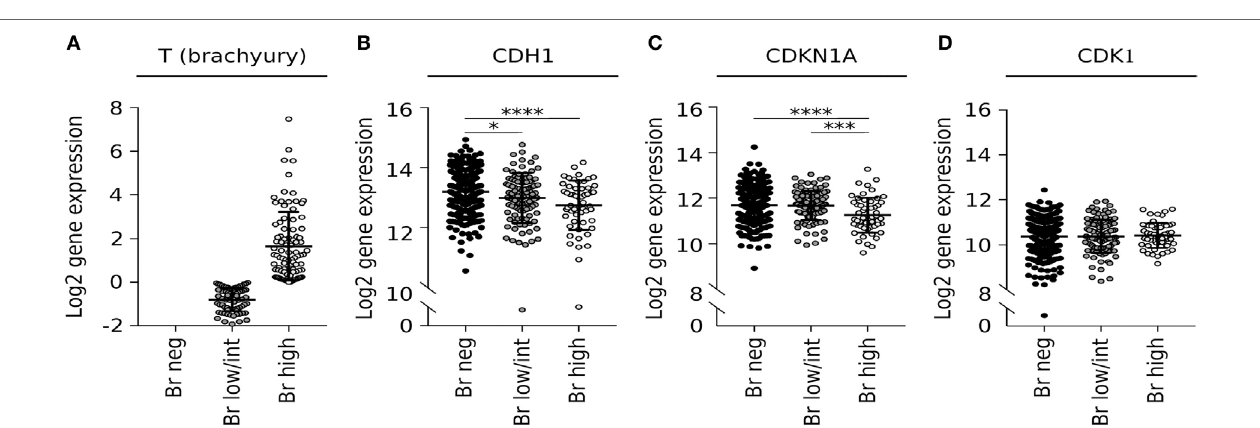
FigUre 6 | Brachyury mRNA correlates with low expression of CDKN1A in lung squamous cell carcinoma samples. Analysis of expression of (a) brachyury ( T ), (B) E-cadherin ( CDH1 ), (c) p21 ( CDKN1A ), and (D) CDK1 transcripts in the LUSC The Cancer Genome Atlas dataset tabulated according to the level of brachyury